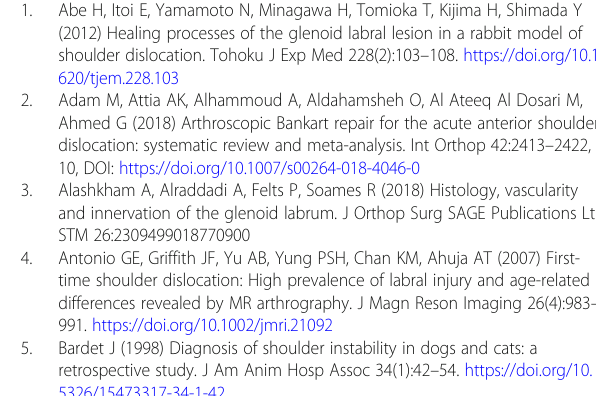
Additional file 1: Supplemental Figure 1. Lower magnification safranin-O-stained sections of the glenocapsular junction at each clock- face position across species. Box on human 12 o ’ clock image (top left) in- dicates higher magnification region of interest show in Supplemental Figure 2. Additional file 2: Supplemental Figure 2. Higher magnification Safranin-O-stained sections of the glenocapsular junction at each clock- face position across species.